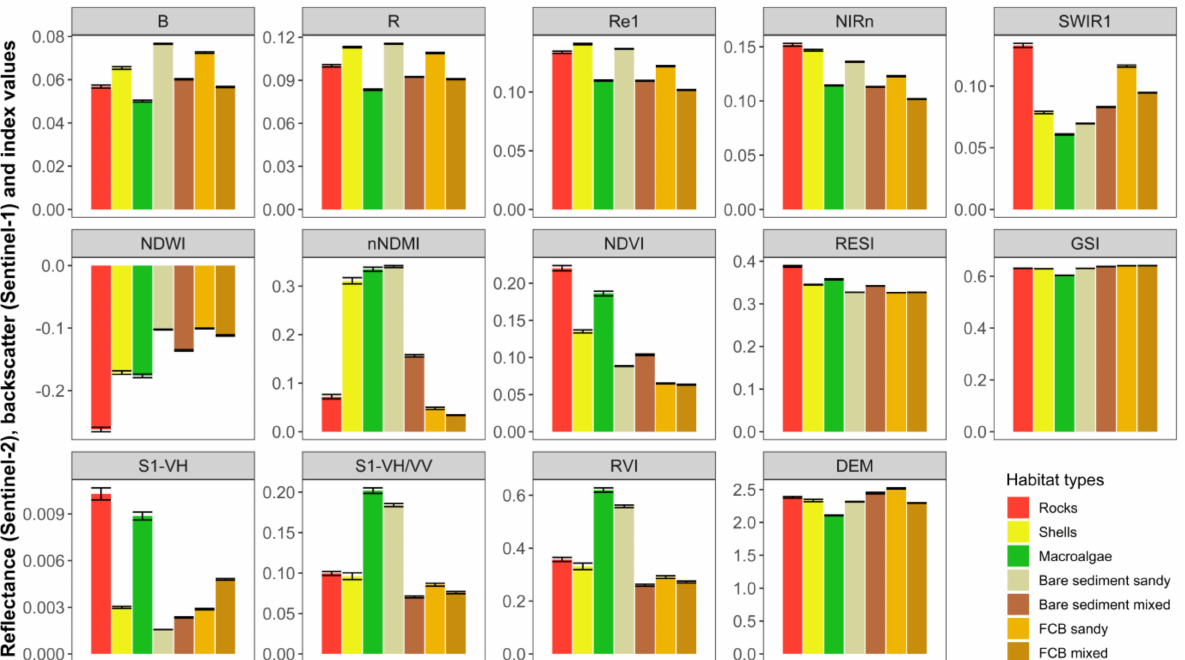
Figure 7. Mean ± SE reflectance, backscatter, and index values of the 14 best predictors for each of the seven habitat types classified in the intertidal flats of the Bijag ó s Archipelago.